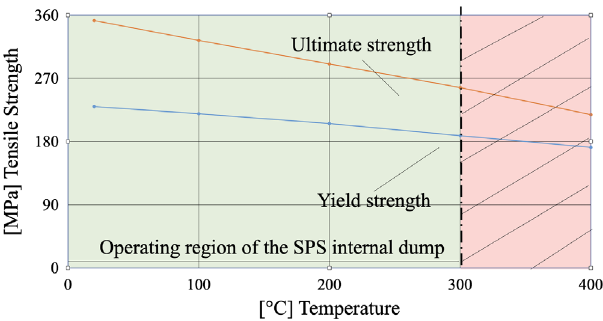
FIG. 16. Yield and ultimate strength of precipitation